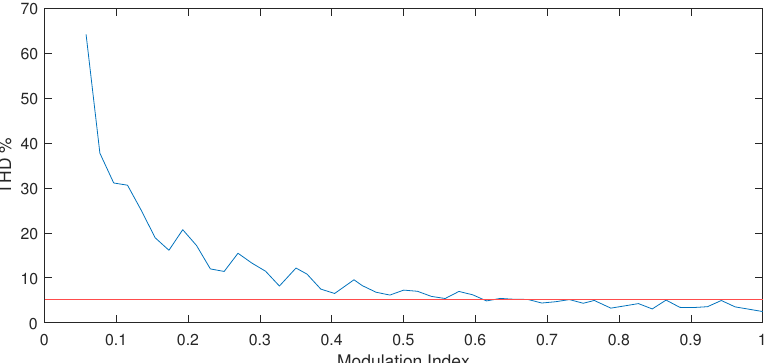
Figure 8. THD for different modulation